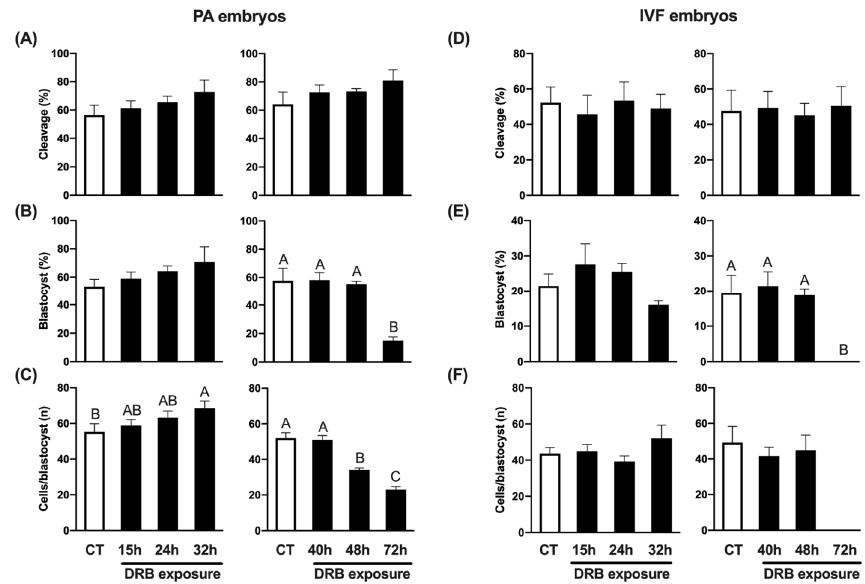
Figure 1. Effect of exposure to DRB for different times on development of PA and IVF embryos. ( A ) Cleavage rates of PA embryos treated with DRB for 0 h (CT, n = 152), 15 h (n = 151), 24 h (n = 152) and 32 h (n = 153) (left graphic), or 0 h (CT, n = 198), 40 h (n = 195), 48 h (n = 194) and 72 h (n = 197) (right graphic). ( B ) Blastocyst rates of PA embryos treated with DRB for 0 h (CT, n = 88), 15 h (n = 95), 24 h (n = 100) and 32 h (n = 97) (left graphic), or 0 h (CT, n = 125), 40 h (n = 141), 48 h (n = 142) and 72 h (n = 157) (right graphic). ( C ) Average number of cells per blastocyst in PA embryos treated with DRB for 0 h (CT, n = 47), 15 h (n = 57), 24 h (n = 63) and 32 h (n = 66) (left graphic), or 0 h (CT, n = 72), 40 h (n = 82), 48 h (n = 79) and 72 h (n = 24) (right graphic). ( D ) Cleavage rates of IVF embryos treated with DRB for 0 h (CT, n = 275), 15 h (n = 281), 24 h (n = 267) and 32 h (n = 279) (left graphic), or 0 h (CT, n = 215), 40 h (n = 212), 48 h (n = 216) and 72 h (n = 213) (right graphic). ( E ) Blastocyst rates of IVF embryos treated with DRB for 0 h (CT, n = 148), 15 h (n = 135), 24 h (n = 149) and 32 h (n = 141) (left graphic), or 0 h (CT, n = 99), 40 h (n = 102), 48 h (n = 99) and 72 h (n = 109) (right graphic). ( F ) Average number of cells per blastocyst in IVF embryos treated with DRB for 0 h (CT, n = 33), 15 h (n = 32), 24 h (n = 40) and 32 h (n = 22) (left graphic), or 0 h (CT, n = 21), 40 h (n = 21), 48 h (n = 18) and 72 h (n = 0) (right graphic). For cleavage results, “n” refers to number of activated/fertilized oocytes per group; for blastocysts results, “n” refers to number of cleaved embryos per group; and for cells/blastocyst results, “n” refers to number of blastocysts analyzed per group. Different letters indicate statistical differences between DRB exposure times within each experiment ( p < 0.05).